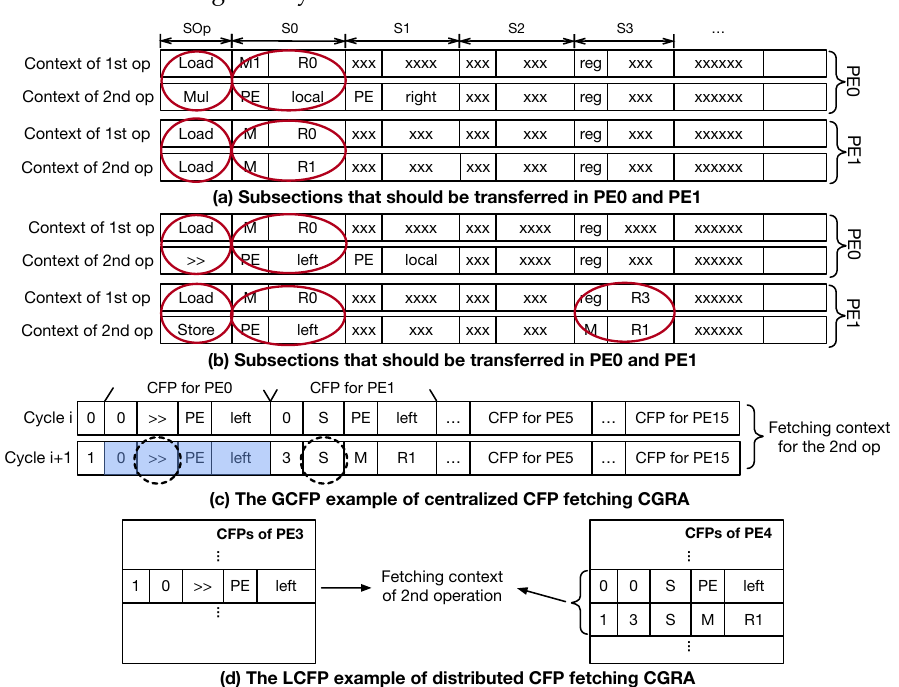
Figure 9. The compressed context-fetching